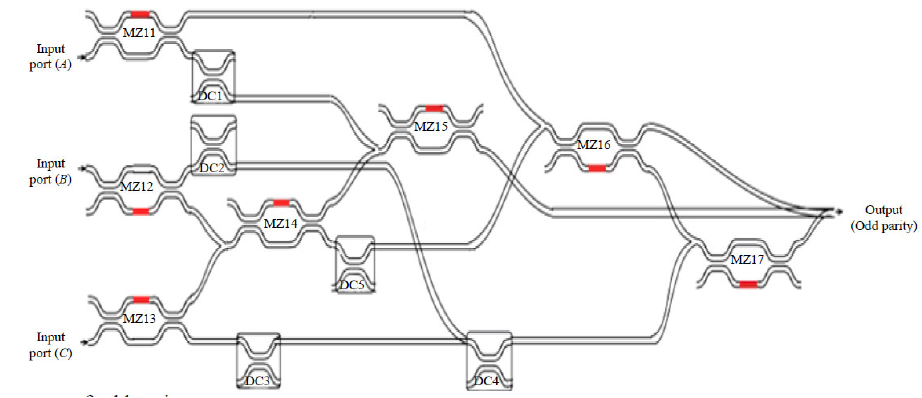
Fig. 7 Block diagram of odd parity